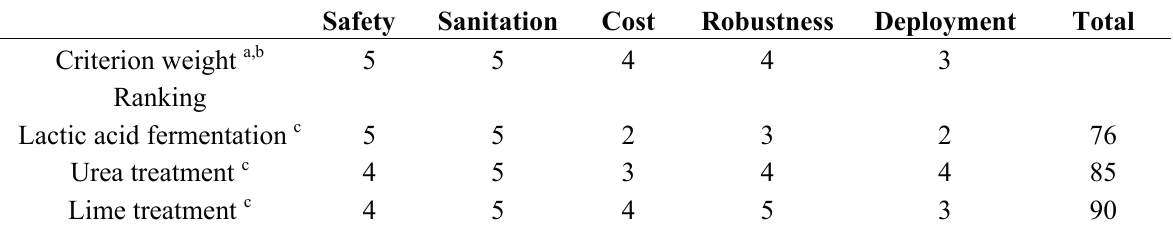
Table 5. Multicriteria